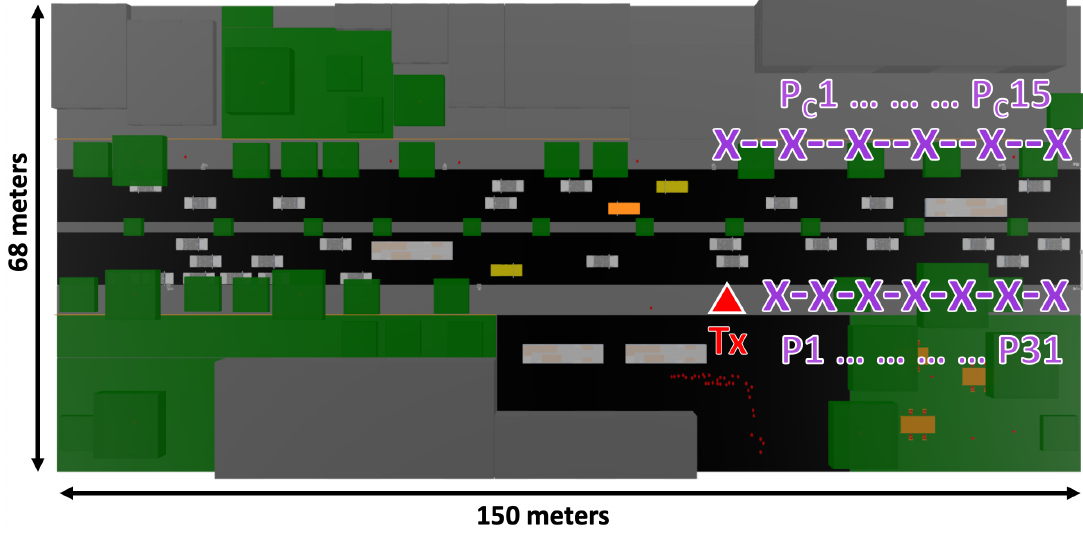
Figure 8. Aerial view of the measurement schematic approach followed in the measurement campaign with the transmitter location depicted, as well as the measurements points